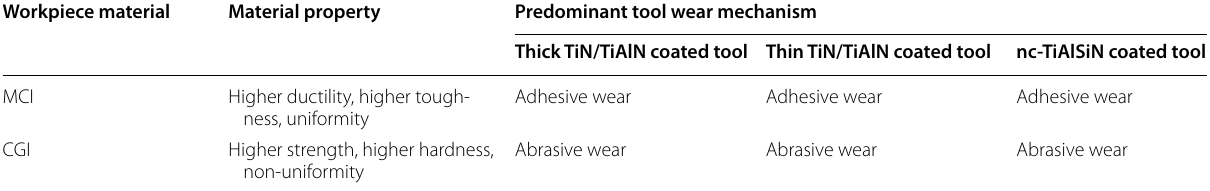
Table 4 Comparison of tool wear mechanisms in MCI and CGI turning Workpiece material